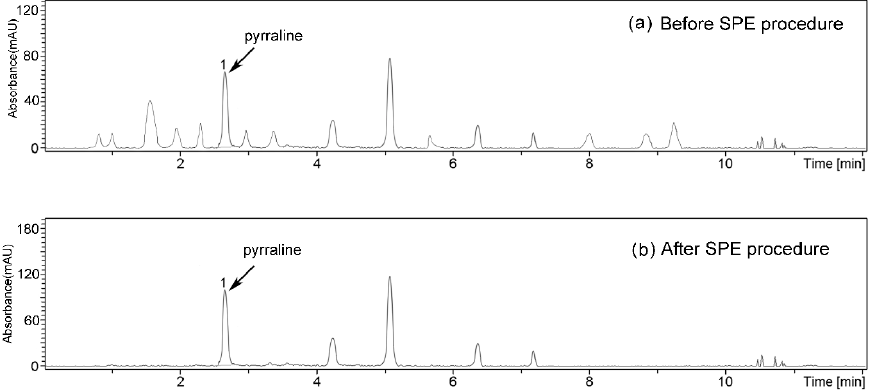
Figure 5. UPLC-UV chromatogram recorded at 297 nm of pyrraline in PEDs: ( a ) before SPE procedure; and ( b ) after SPE procedure.